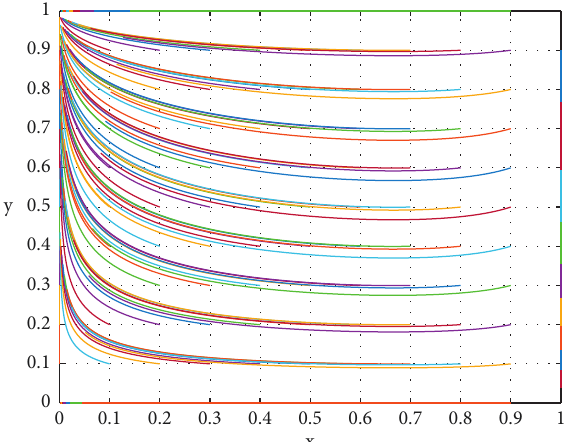
Figure 8: Evolution path when μ > ηβ > α and ε > ηβ − α > 0. Figure 9: Evolution path when ηβ > μ > α and ε > ηβ − α > 0.